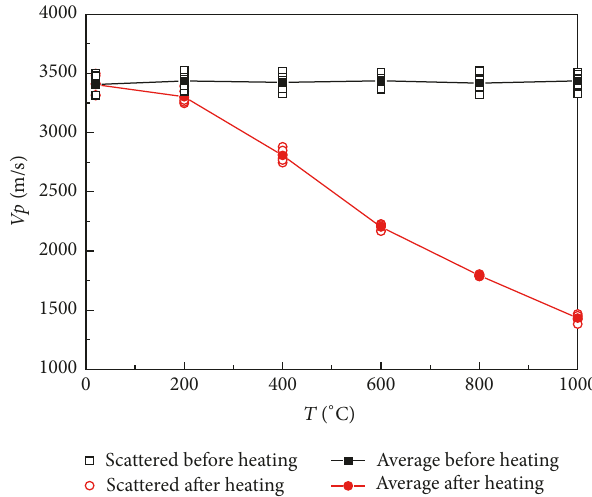
Figure 1: Relation of ultrasonic P-wave velocity before and after temperature treatment.